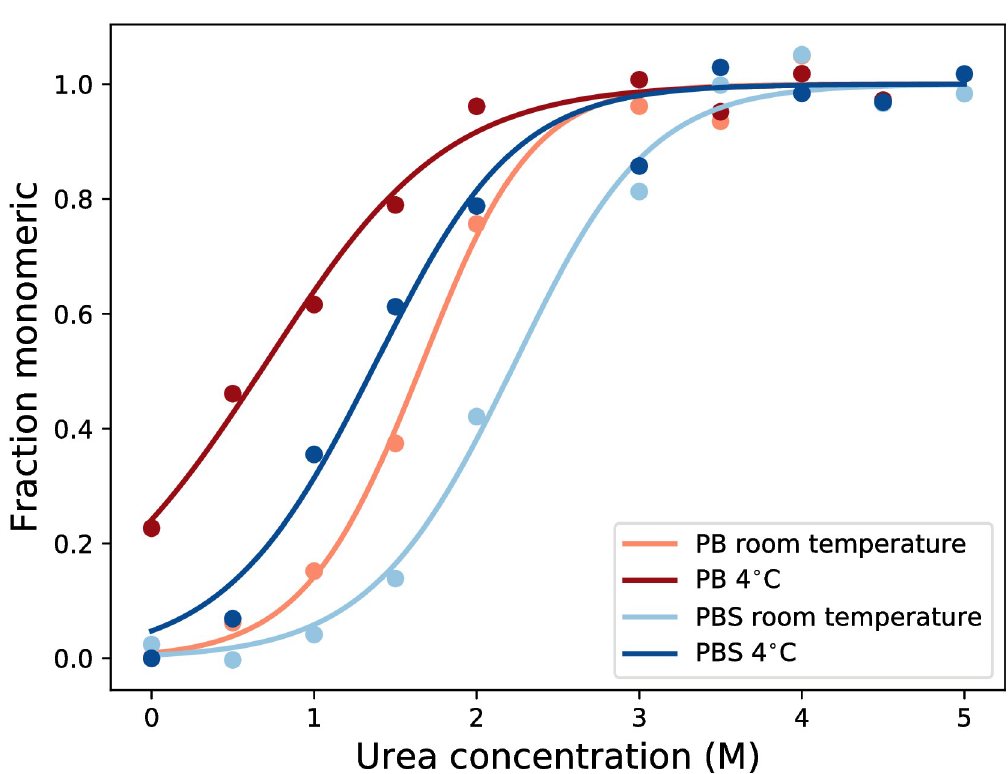
Fig 6. The effect of changes in ionic strength and temperature on the stability of α -synuclein fibrils. We show the fraction of depolymerised fibrils as a function of urea concentration, determined by intrinsic fluorescence using the F94W mutant of α - synuclein. Fibril destabilisation was measured at four different conditions: at high (dark, 10 mM PB + 150 mM NaCl) and low (light, 10 mM PB) ionic strength, and at 28˚C (red) and 4˚C. The depolymerisation curves were fitted with the isodesmic linear polymerisation model, Eq 12. The data shows that fibrils become less stable at low temperatures, and that an increase in ionic strength stabilises the fibrils by screening repulsive charges in the fibril.